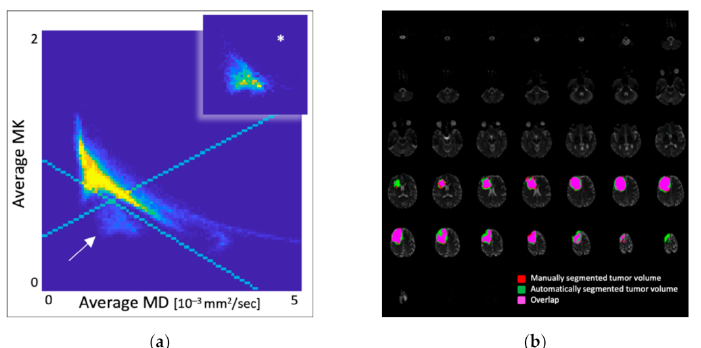
Figure 20. Scatter plots: ( a ) Scatter plot with pathological MK and MD values distribution in the whole brain. The white arrow shows the separate voxels area with glioma-specific diffusion properties; the asterisked field shows the manual glioma segmentation’s voxel distribution; ( b ) corresponding batch of MD images with the overlaid labels of diffusion-based automatic segmentation (green) and the manual segmentation (red) of the tumor and their spatial overlap (pink).